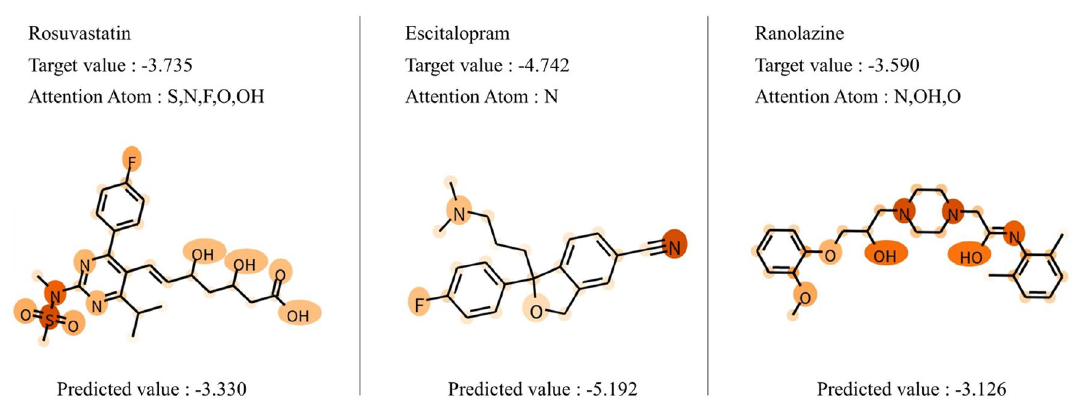
Figure 5. Predicted water solubility for three commercial medicines. The unit of water solubility is